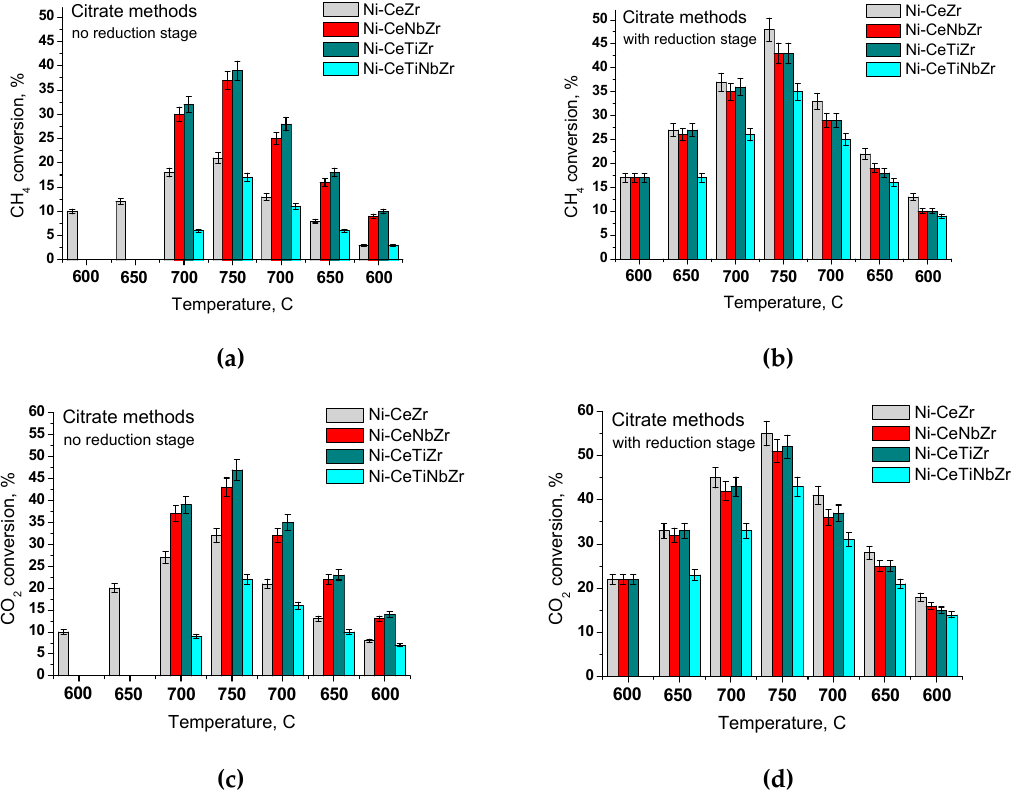
Figure 12. Steady-state conversions at different temperatures over catalysts prepared by citrate methods with ( b , d ) or without ( a , c ) preliminary reduction stage.